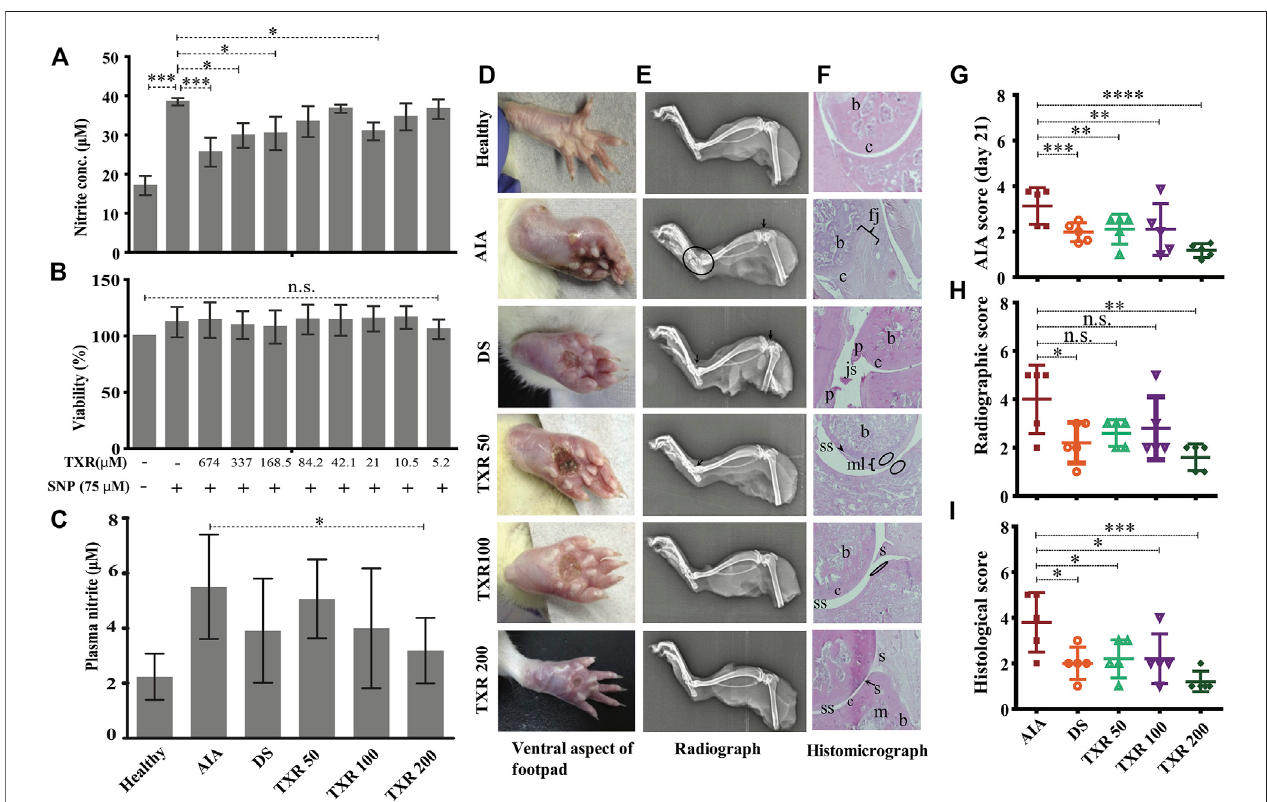
FIGURE 2 | TXR has limited cytotoxicity in RAW 264.7 cell lines and anti-arthritic potential in AIA rats. The released nitrite concentration in the cell supernatant (A) and viability (B) of the RAW 264.7 cells with or without TXR. (C) Blood plasma nitrite content in the experimental animals using Griess nitrite assay. (D) Representative pictures of the ventral aspect of footpads. (E) Radiograph of the tibiotarsal joints. Arrows indicate the osteophyte formation, and the oval structure mark the extent of osteolysis. (F) Representative histological micrograph of the hematoxylin and eosin-stained slides of rat joints. (Original magni fi cation ×10) (js: joint space; c: cartilage;b:bone;p:pannus;s:synovium;mls:multilayeredsynovialmembrane;fj:fusedjoints;andm:matrix).Thearrowheadsindicatethedamageinthesynoviallining and theovalstructures showneutrophilsintheepiphysealcartilage. (G) AIAscoreatday21. (H) Thecumulativeradiographicscore. (I) Histologicalscore.AIA:adjuvant- induced arthritis; DS: diclofenac sodium-treated AIA; TXR 50, 100, and 200 mg/kg dose of troxerutin.